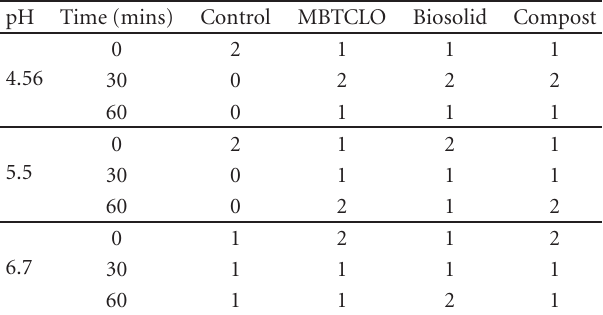
Figure 3: Sewage sludge sample.